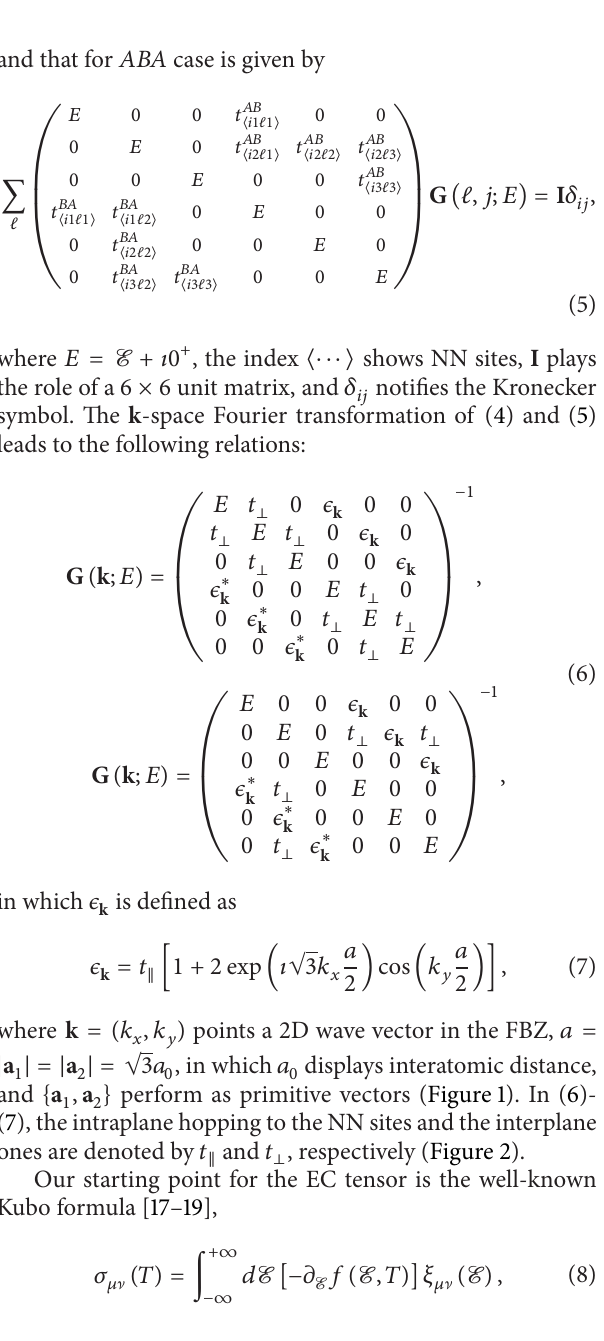
Figure 1: Geometry of monolayer graphene in 𝑥𝑦 plane. The dashed lines illustrate the Bravais lattice unit cell. Each cell includes 𝑁 𝑎 = 2 atoms, which are shown by 𝐴 and 𝐵 . The primitive vectors are denoted by a 1 and a 2 and 𝑎 0 implies the interatomic distance.